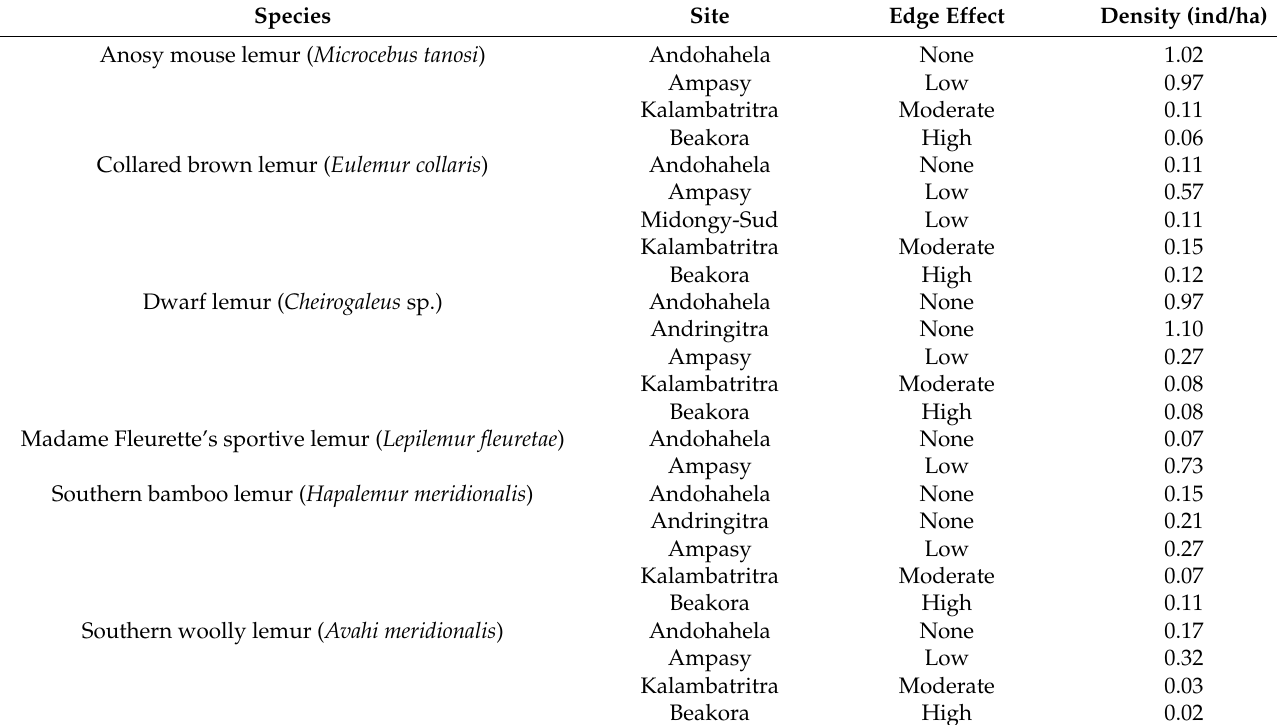
Table 5. Density estimates of lemurs present in the study area and in neighbouring areas in South- East Madagascar. We considered edge effect as low when the total area within 100 m from forest edge in proximity of the coordinates of the study area (~1km radius) is ≤ 20%, moderate for values 20 < x ≤ 50%, high for values >50%. None means that edge is >1km from the coordinates of the study area. Sources: Ampasy (this study); Andohahela [71]; Andringitra [66]; Beakora [68]; Kalambatritra [72,73]; Midongy-Sud